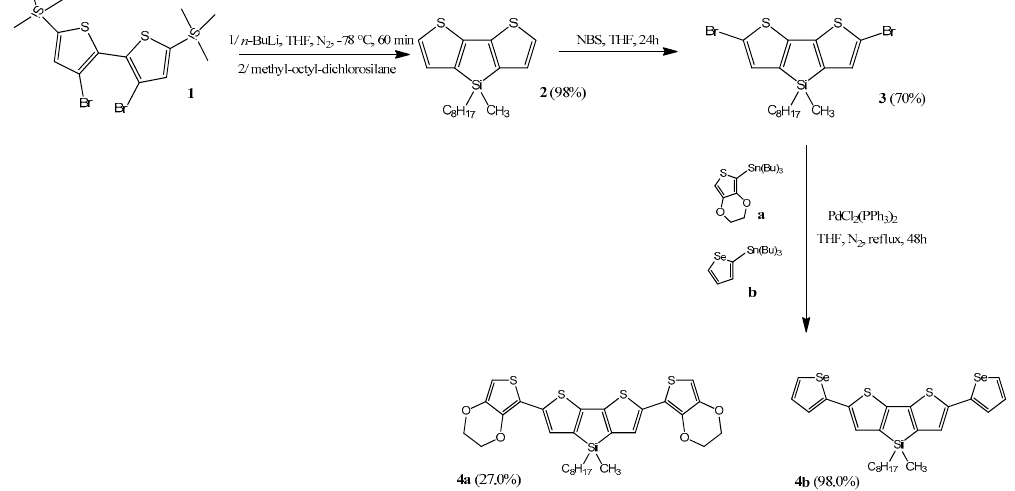
Figure 2. The reaction scheme for the preparation of siloles. NBS: (N-bromosuccinimide), THF: tetrahydrofuran.